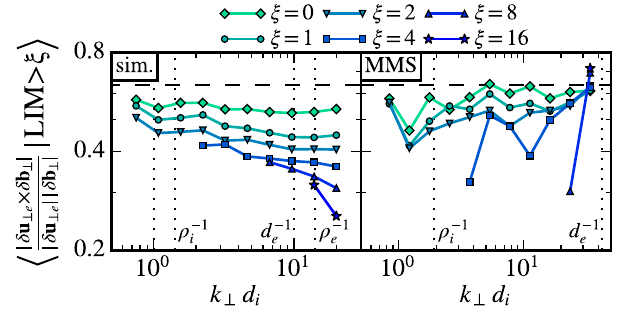
FIG. 8. Sine of the scale-dependent alignment angle between the perpendicular electron fluid velocity and magnetic field, conditionally averaged on a given LIM threshold ξ (see text for details). Dashed horizontal lines indicate the expected value for a randomly distributed